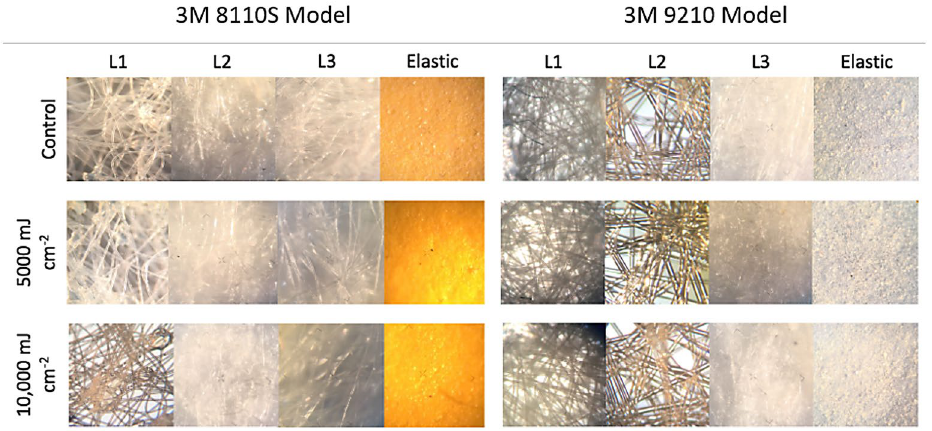
Figure 2. 10 × magnification of individual respirator straps and respirator layers for 8110S and 9210 treated and control respirators as viewed under a compound microscope following 0, 5000 and 10,000 mJ cm −2 exposure to UV-C